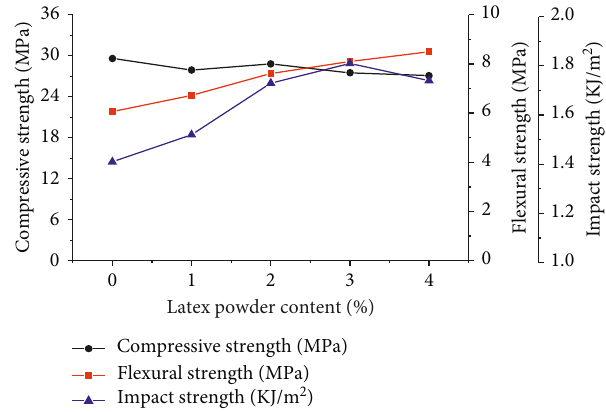
Figure 3: Dependence of latex powder content on mechanical properties of cement slurry. Table 3: Dependence of rubber content on rheological properties of cement slurry.